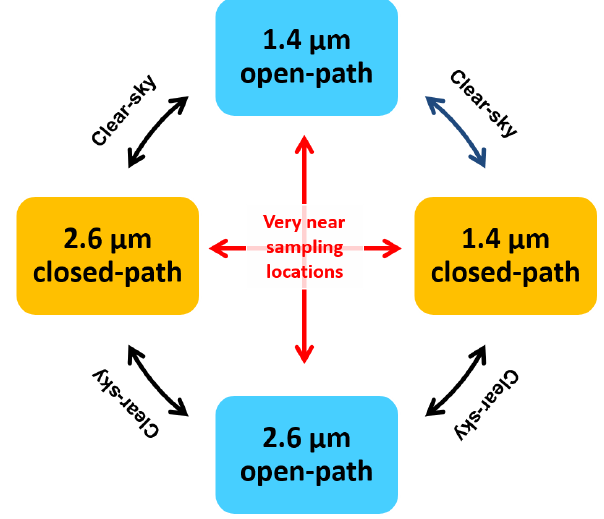
Figure 5. HAI’s self-validation possibilities under clear-sky condi- tions (black) and measurement redundancies under all atmospheric conditions (red). For details see